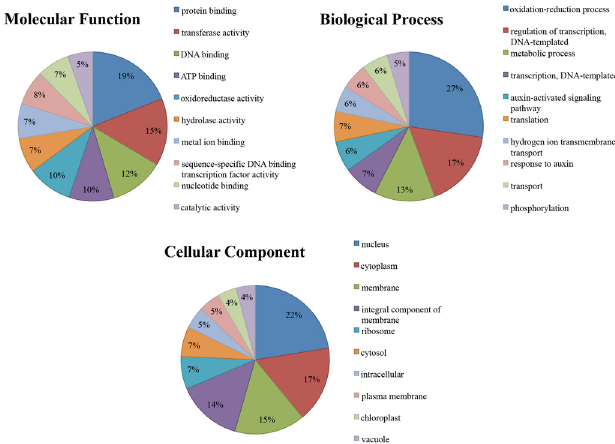
Fig 11. The top ten GO terms for the three GO categories for the targets identified for the conserved cassava miRNAs.